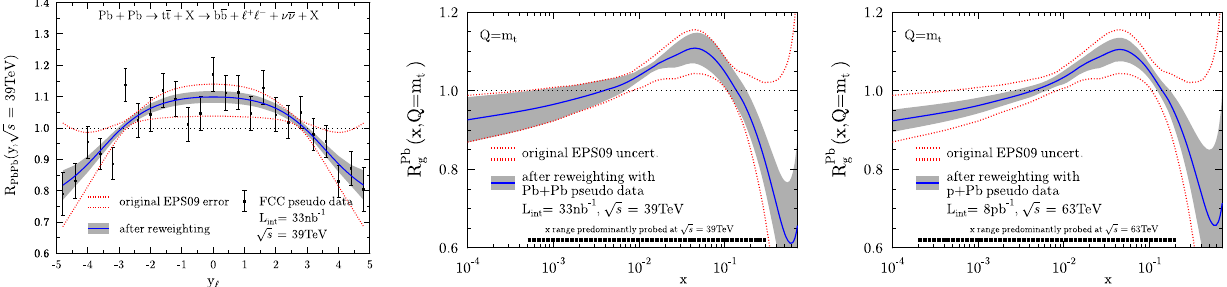
Fig. 16.8 Left: FCC pseudodata for the nuclear modification factor for top production in PbPb collisions. Middle and right: original EPS09 gluon nuclear modification at Q = m top and estimated improvement